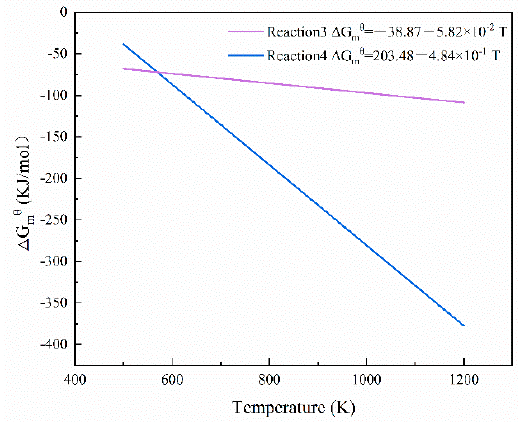
Figure 1. The Gibbs free energy of reactions 3 and 4.